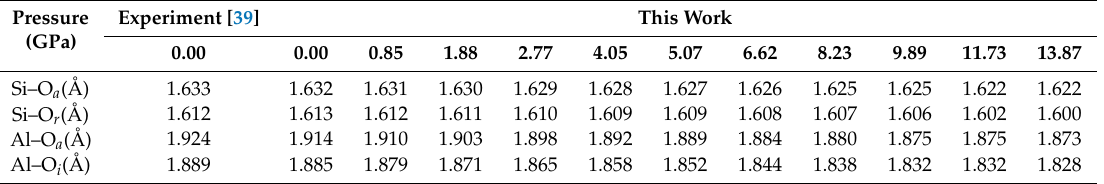
Table 2. Compared with experimental values, the calculated average bond lengths in